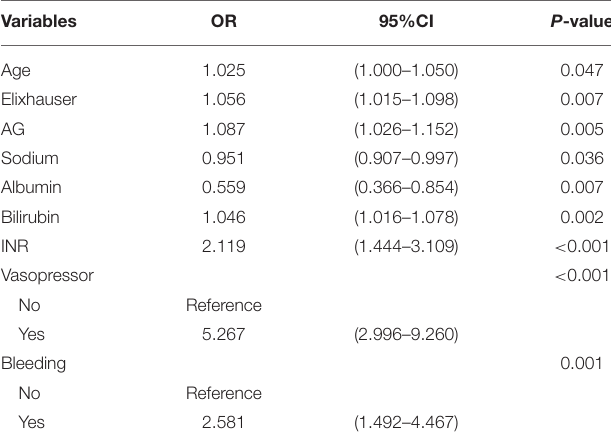
TABLE 2 | Factors independently associated with in-hospital death in LCEV patients.